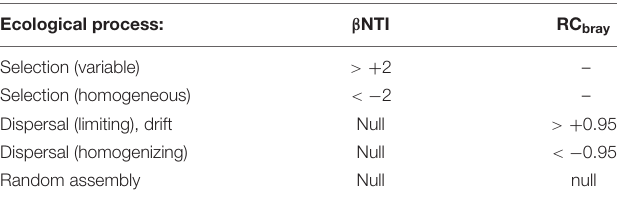
TABLE 2 | Beta diversity relationship to ecological process (Stegen et al.,